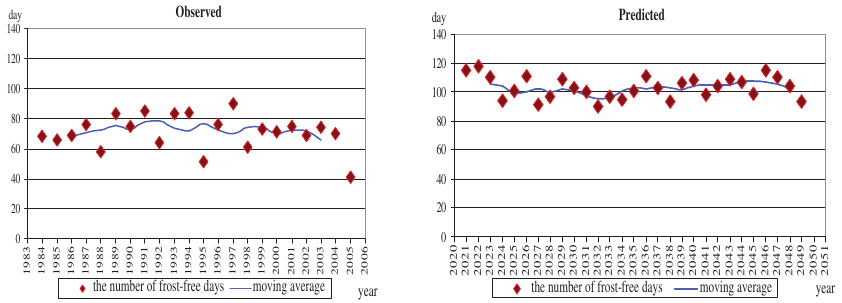
Figure 2. Number of frost-free days at Újfehértó in the past and estimated according to the model RegCM3.1 during the rest period of sour cherry (early October – end of March)